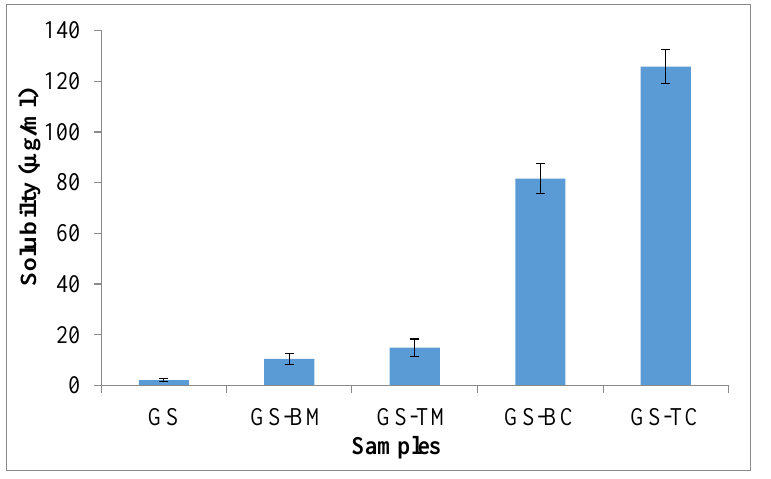
Figure 3. Saturation solubility of Genistein (GS), binary physical mixture (GS-BM), ternary physical mixture (GS-TM), genistein binary complex (GS-BC) and genistein ternary complex (GS-TC).